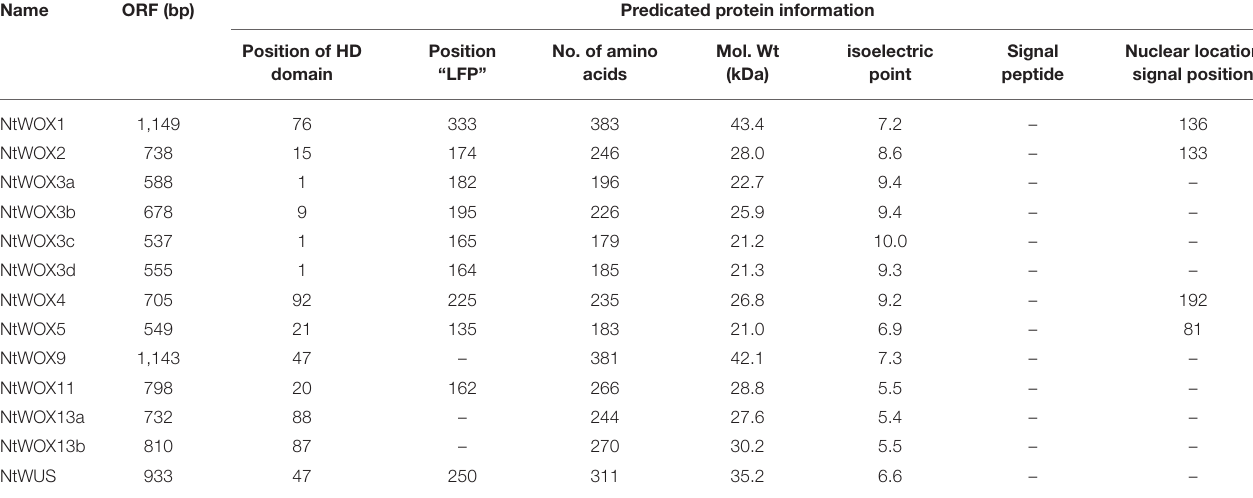
TABLE 1 | Detailed information for WOX family proteins in